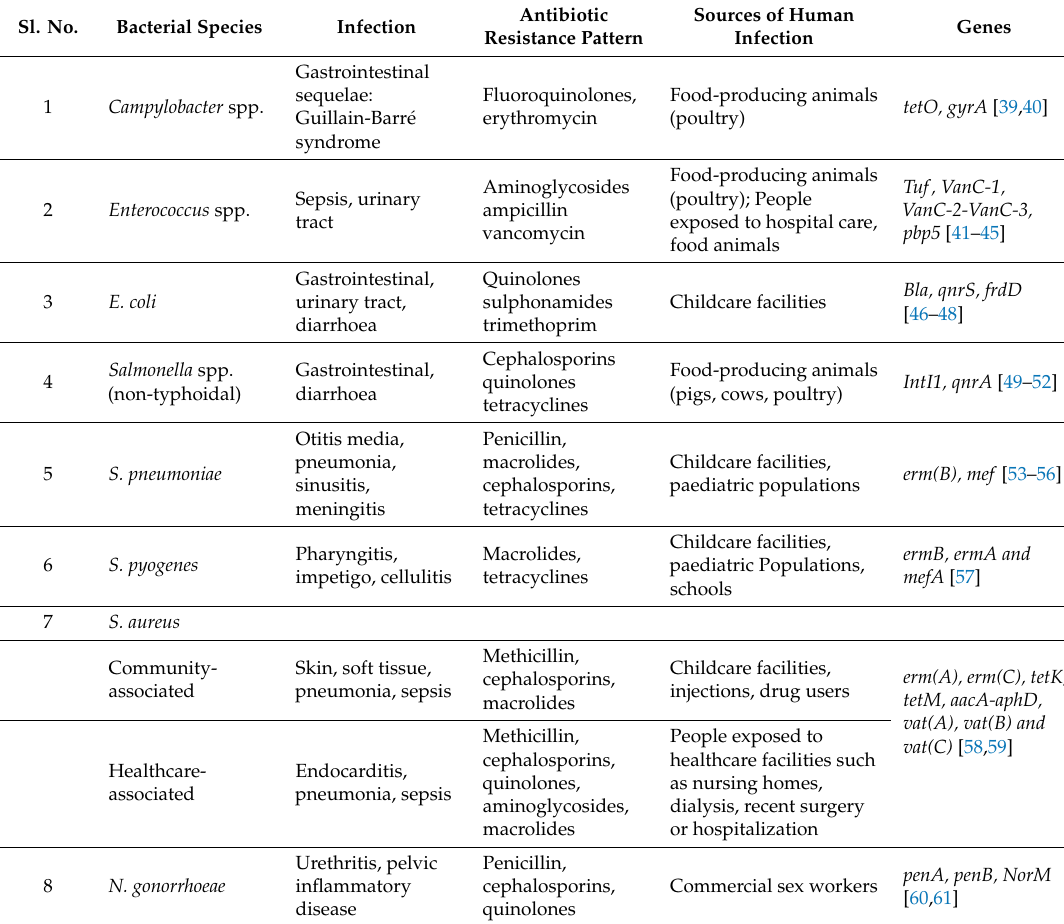
Table 3. ARG in animal production